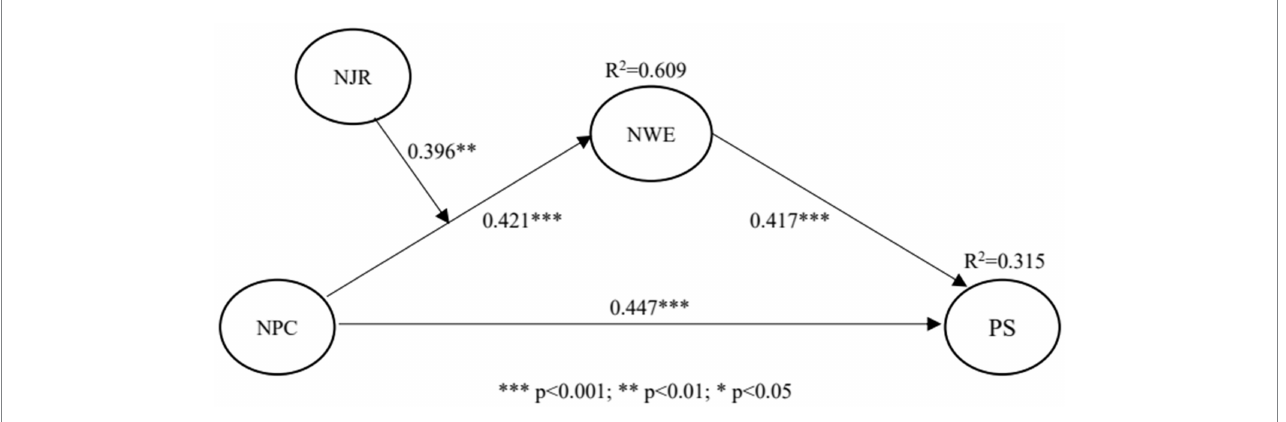
FIGURE 2 Path coefficients and R 2 of the structural model.